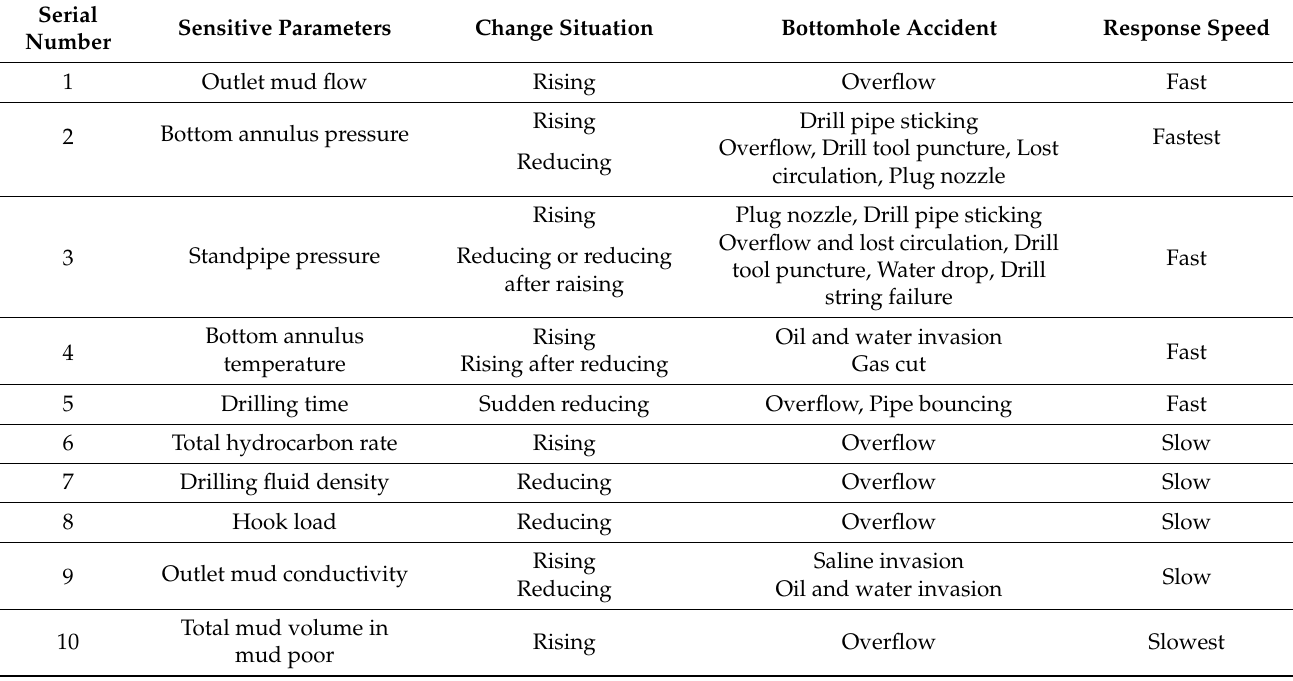
Table 2. Optimized overflow sensitive